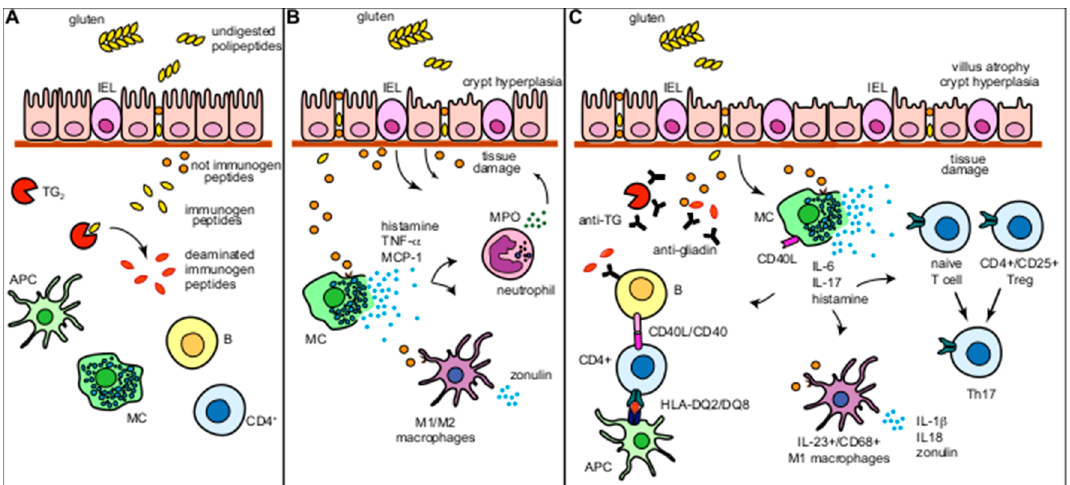
Figure 3. Schematic representation of mast cell’s (MC) role in the pathophysiology of the coeliac disease (CD). ( A ) Under basal condition, MCs localize mainly in the lamina propria of the intestinal mucosa. Undigested gluten peptides cross the epithelial barrier and reach the lamina propria where they are deaminated locally by the tissue transglutaminase 2 (TG2). Immunogenic deaminated peptides can bind the HLA-DQ2 or HLA-DQ8 molecules and can be presented to T-helper cells resulting in adaptive immune response activation. Non-immunogenic peptides can bind and activate the response of innate immune cells. ( B ) Tissue resident MCs can directly react to non-immunogenic toxic p31-43 fragment of gliadin by releasing preformed and newly synthetized mediators. These mediators are able to recruit and activate local macrophage and neutrophils contributing with MC to generate the tissue damage in the early phase of the disease (Marsh 1). ( C ) In the intestinal lesions of CD patients characterized by high Marsh grades (Marsh 2 and 3), MCs become a significant source of pro-inflammatory cytokines (IL-6 and IL-17). By the release of IL-6 and by the expression of CD40L, MC sustain B cell in the production of IgA, while MC-derived IL-6 and IL-17 promote the skew of local Treg cells into Th17. The cytokine milieu created by MCs also favors the polarization of the microenvironment toward a M1 phenotype. APC, antigen presenting cell; MPO, myeloperoxidase; TG2, transglutaminase 2.